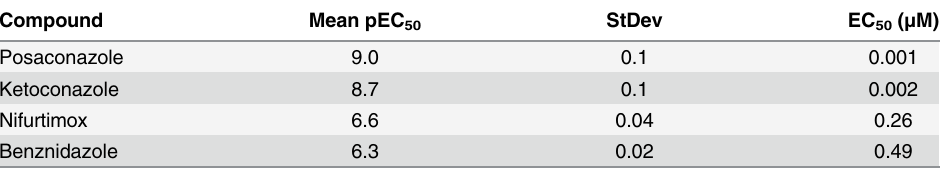
Table 1. Potencies against intracellular T . cruzi for control compounds (N =